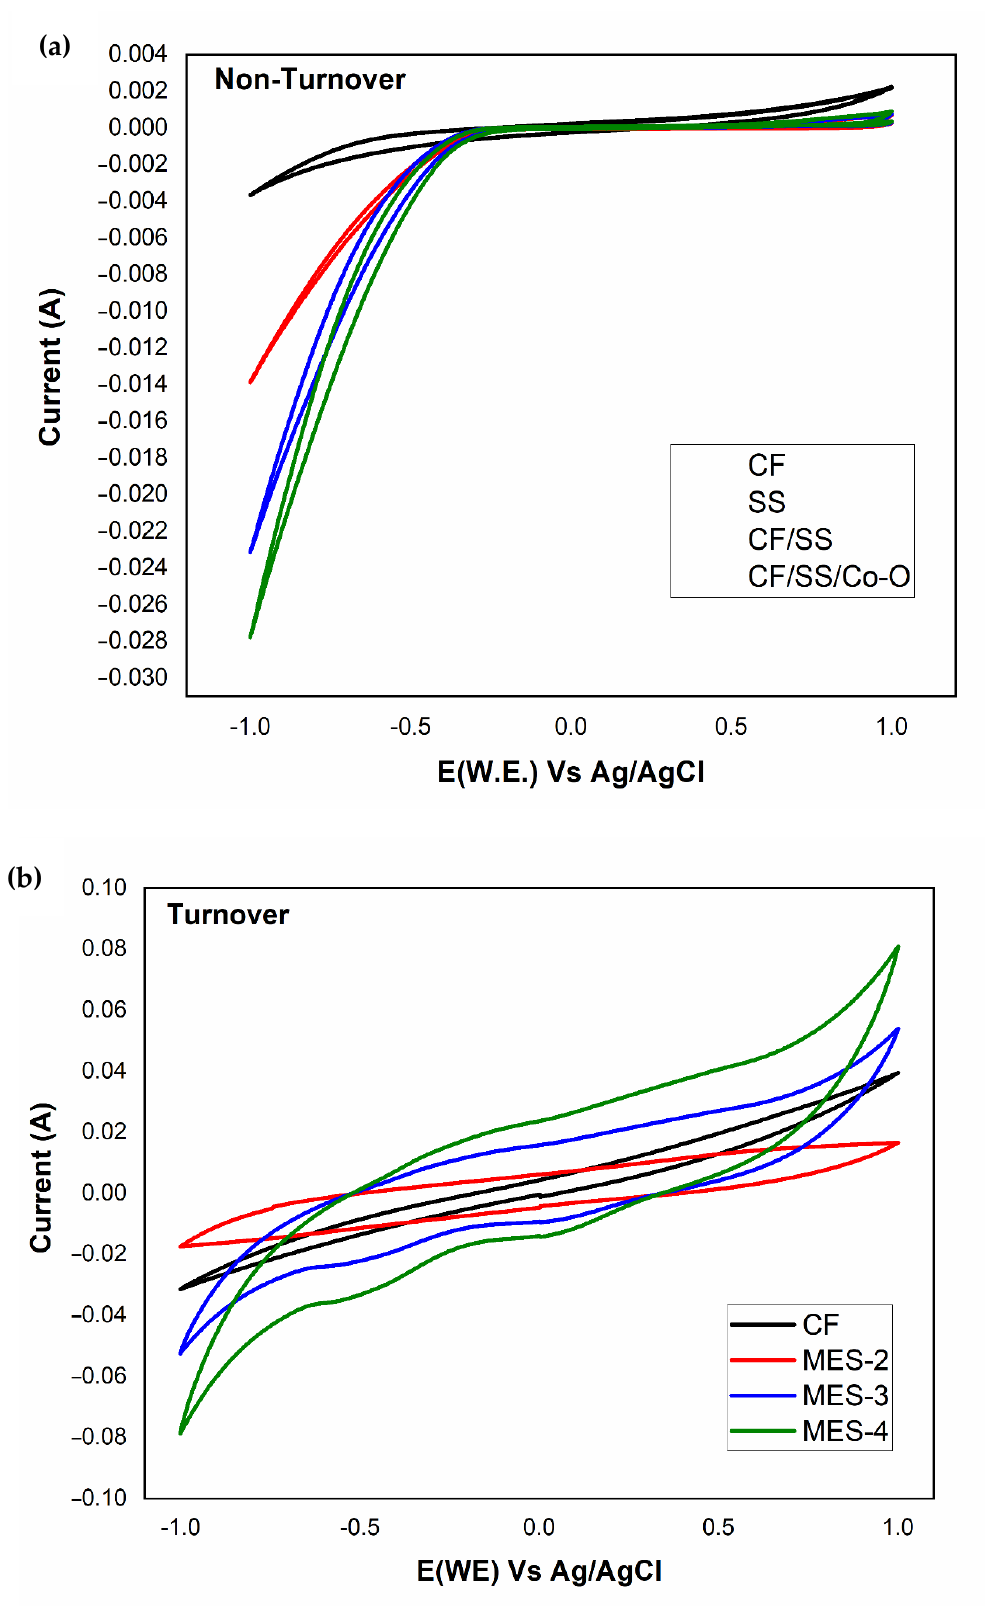
Figure 6. Cyclic voltammograms; ( a ) non-turnover and ( b ) turnover for the different electrode materials in MES.